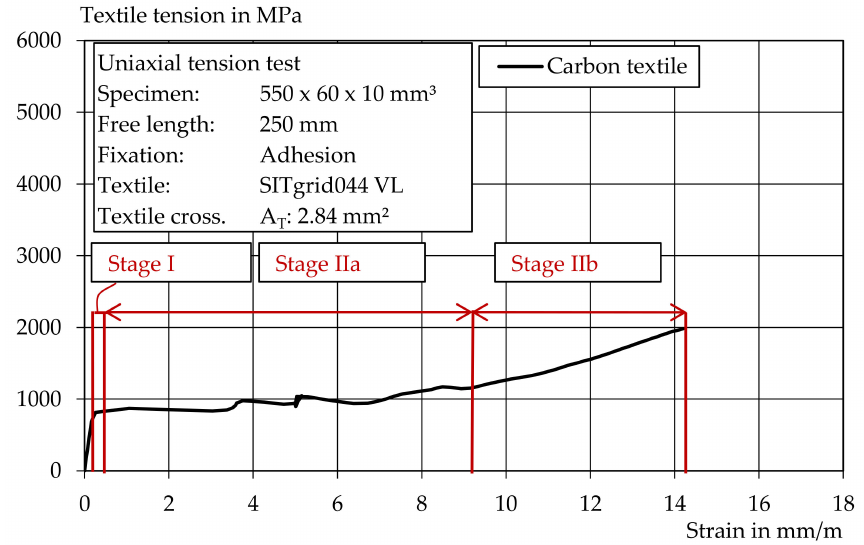
Figure 16. Stress–strain curve in a uniaxial tension test with carbon textile.